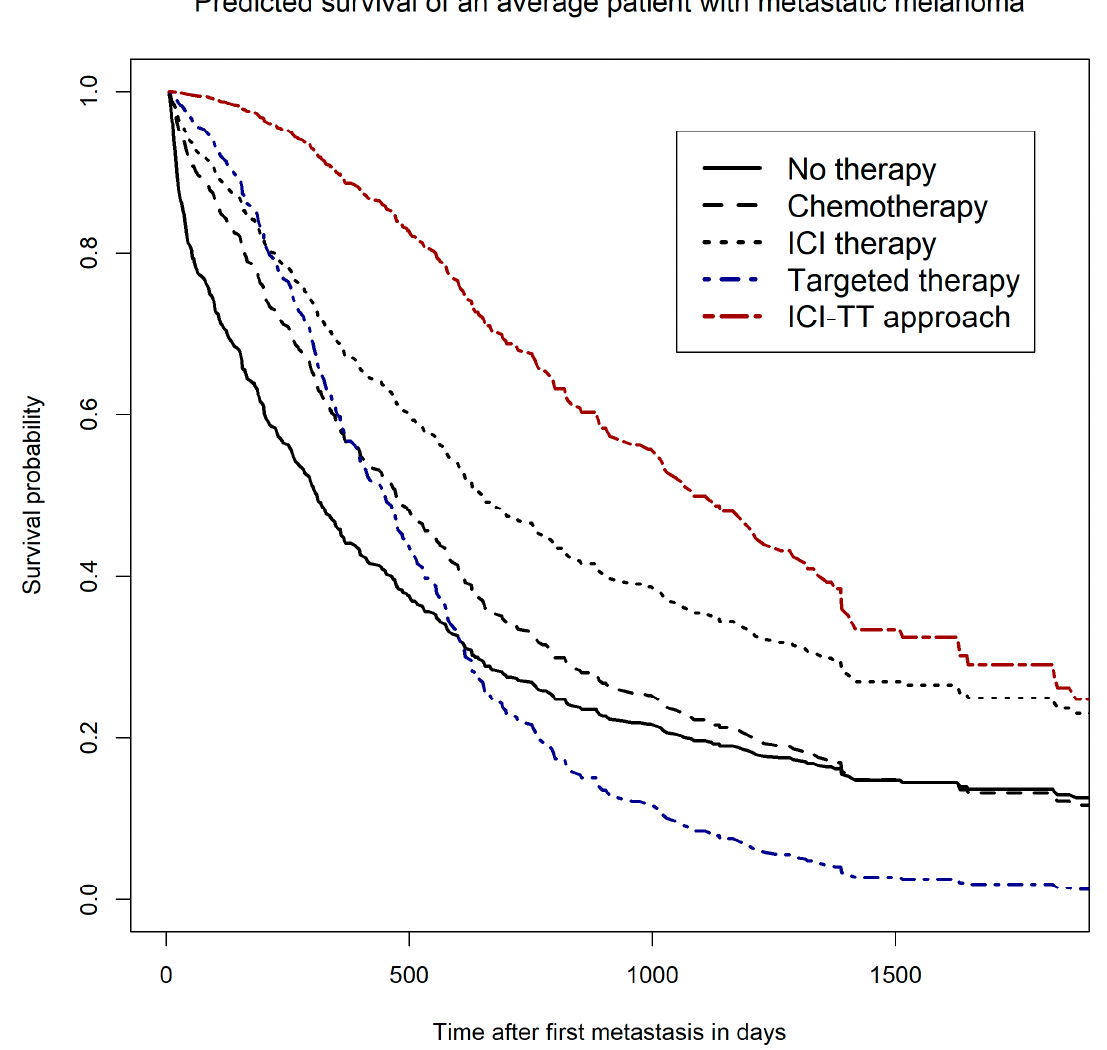
Figure 2. Predicted survival of an average patient (mean adjusted) since first metastasis for chemotherapy, immune checkpoint inhibitor therapy (ICI), targeted therapy (TT), sequential use of ICI and TT, and no documented systemic therapy.